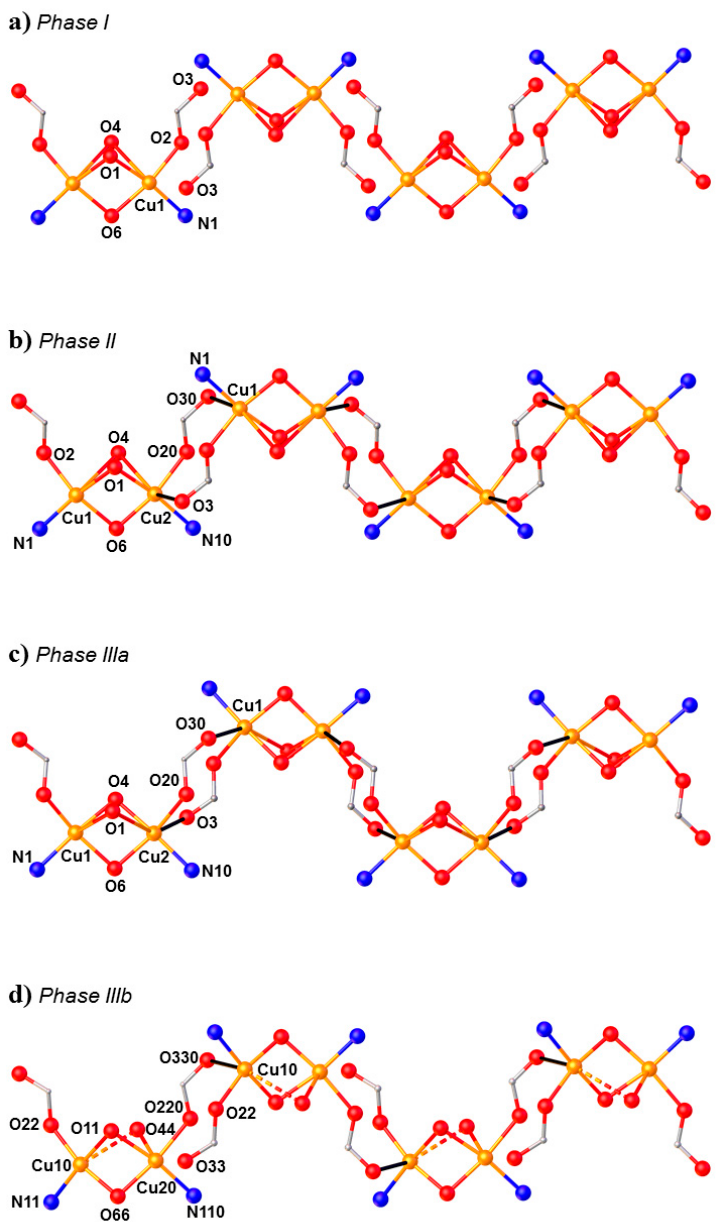
Figure 10. ( a ) The arrangement of the molecules in Phase I at ambient pressure. ( b ) Formation of the polymer in Phase II at 2.95 GPa. ( c , d ) The two crystallographically independent polymer chains of Phase III at 4.23 GPa. Colour code: Cu = orange, O = red and N = blue. H atoms and most uncoordinated atoms are omitted for